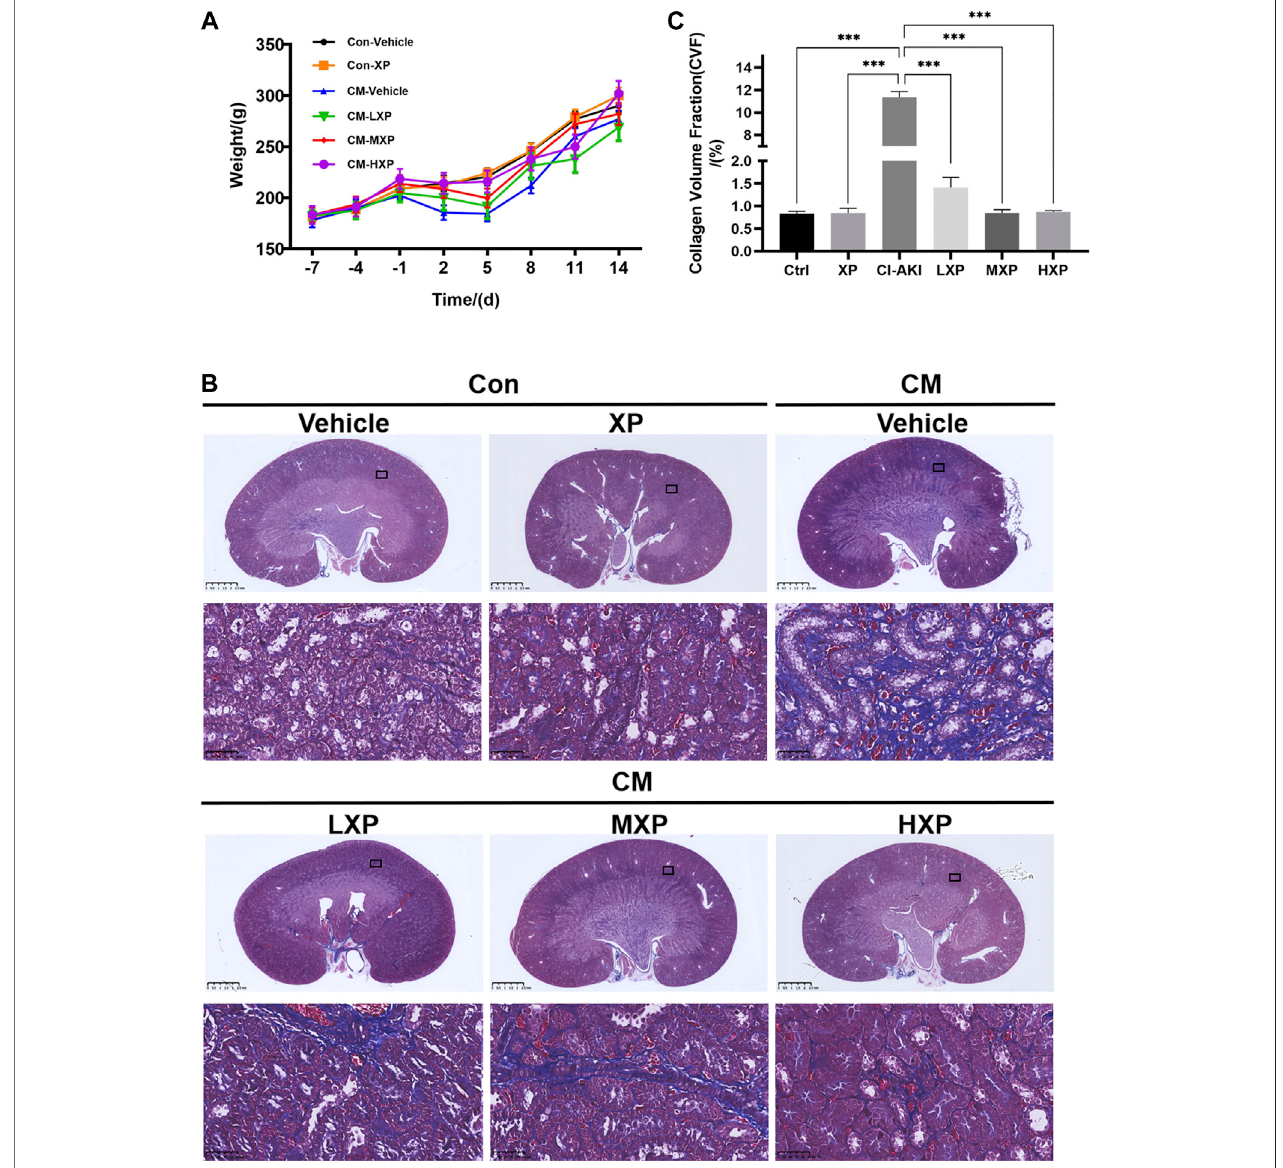
FIGURE 8 | Body weight and Masson ’ s trichrome staining. (A) The rats weight changes with or without treatment with XP during 21 days. (B) Masson ’ s trichrome staining(Magni fi cation: × 400,scalebar:50 μ m)showedanincreased fi brosisstainedinblueiniohexol-receivinganimalswhilesigni fi cantlylesscollagen fi berdeposition was observed in Con-Vehicle group and CM-LXP, CM-MXP, CM-HXP groups. Images presented are representative images. (C) The quanti fi cation of Masson ’ s trichrome staining was presented as collagen volume fraction (CVF) values. Data are presented as mean ± SEM ( n (cid:1) 4 in each group). * p < 0.05; ** p < 0.01; *** p